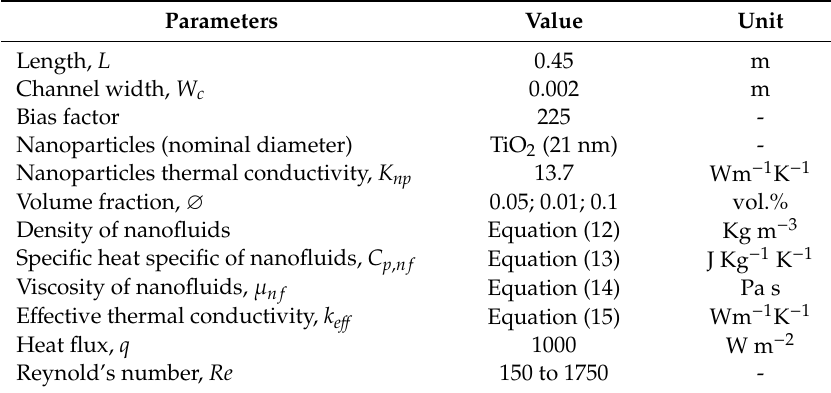
Figure 2. The configuration of the 3-D grid for a square minichannel with a microfin structure. Table 1. Numerical investigation parameters.